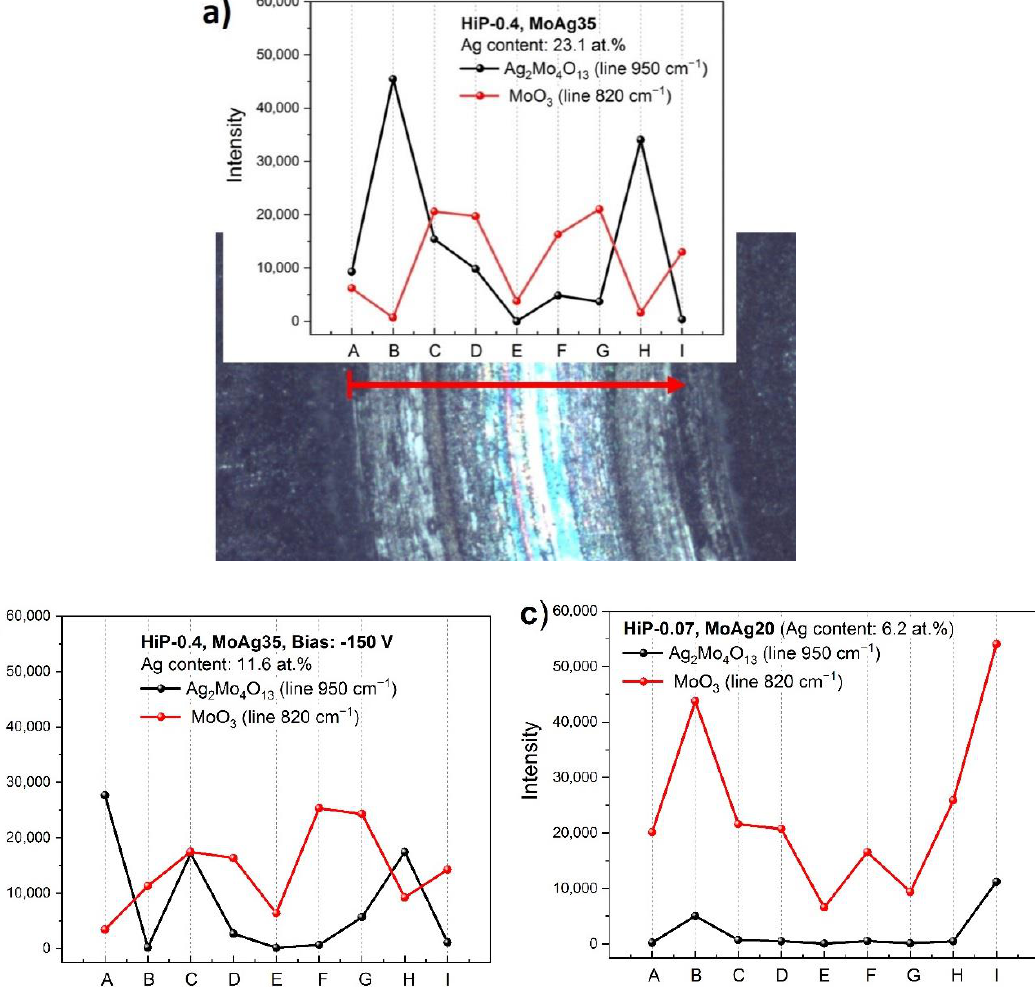
Figure 19. Micro Raman measurements across the wear track after HT tribotests for MoN-Ag coated steel samples with ( a ) 23.1 at.% Ag (HiP-0.4, MoAg35), ( b ) 11.6 at.% Ag (HiP-0.4-bias, MoAg35) and ( c ) 6.2 at.% Ag (HiP-0.07, MoAg20). The length of the red arrow in Figure 19a is about 400 µm (corresponds to wear track width). The Raman intensity of the 820 cm −1 line for MoO 3 (red line) and the Raman intensity of the 950 cm −1 line (black line) for Ag 2 Mo 4 O 13 are plotted vs. the length across the wear track. The measurement positions (A, B, …, I) across the wear tracks are estimated.